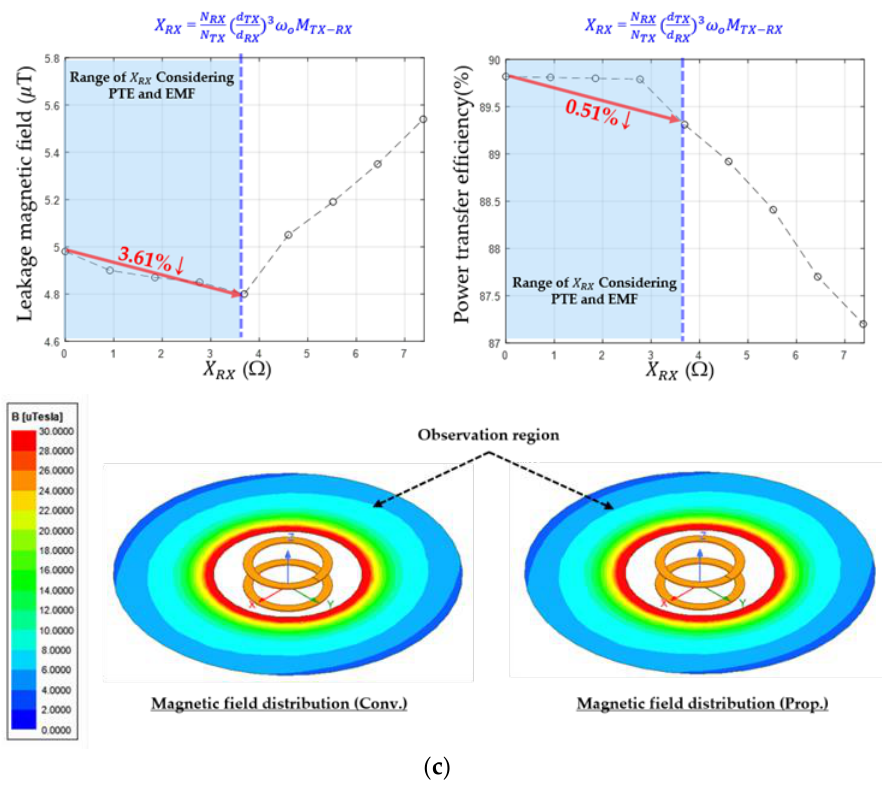
Figure 13. Simulation results (leakage magnetic field, PTE and magnetic field distribution) with variation of the load when the air gap is 70 mm: ( a ) 3.08 Ω; ( b ) 6.17 Ω ; ( c ) 12.34 Ω.